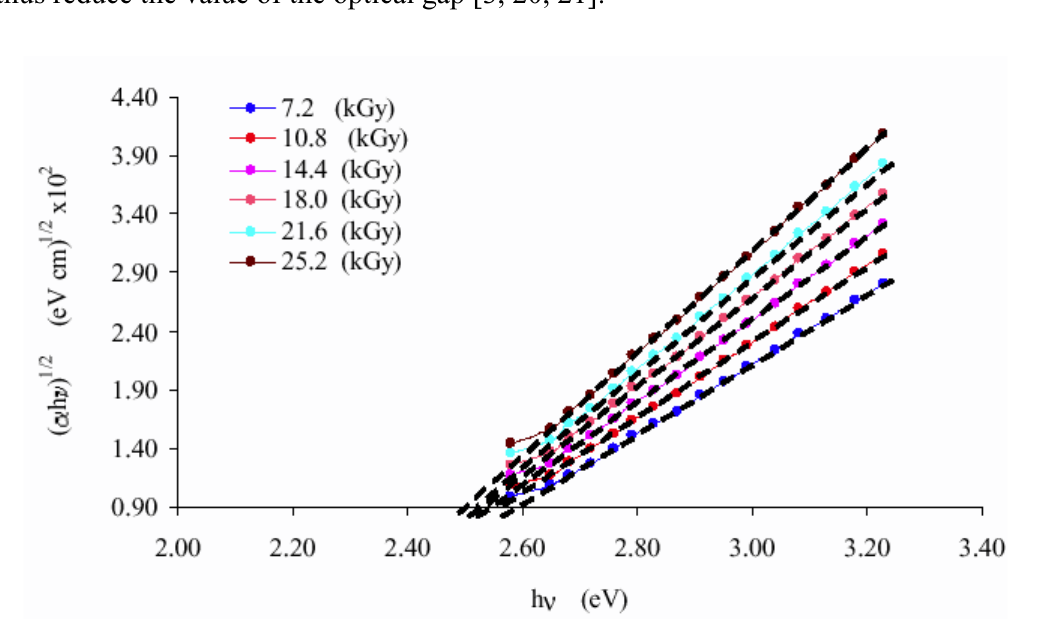
Figure 5. The extrapolations of straight lines for which ( α h ν )1/2 = 0.0 display the radiation induced decrease in the optical band